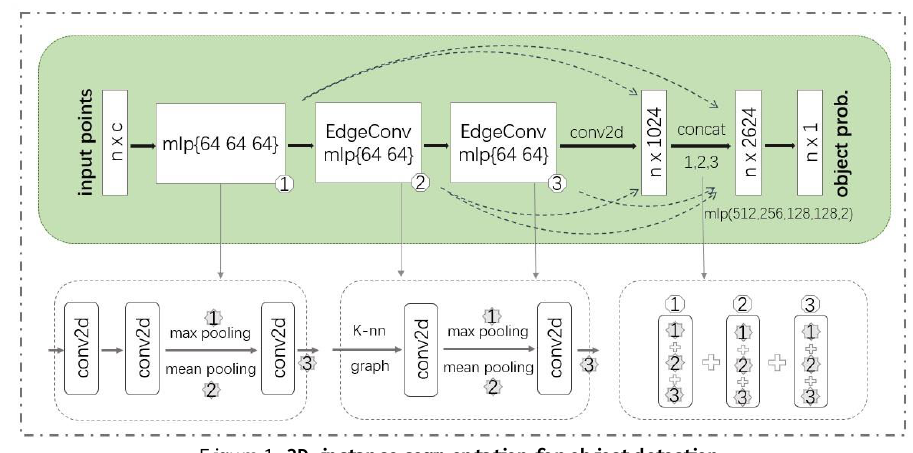
Figure 1. 3D instance segmentation for object detection.